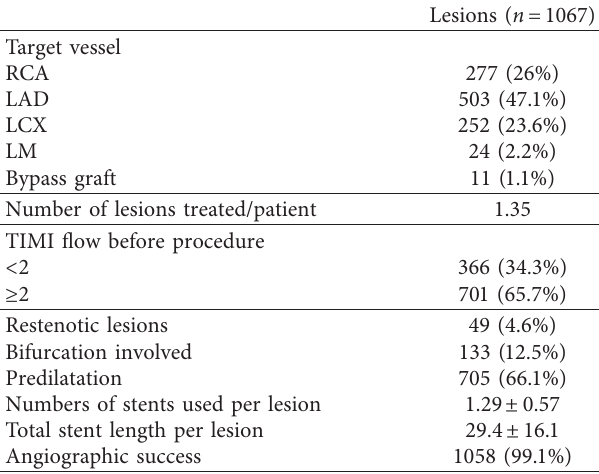
Table 2: Angiographic characteristics.